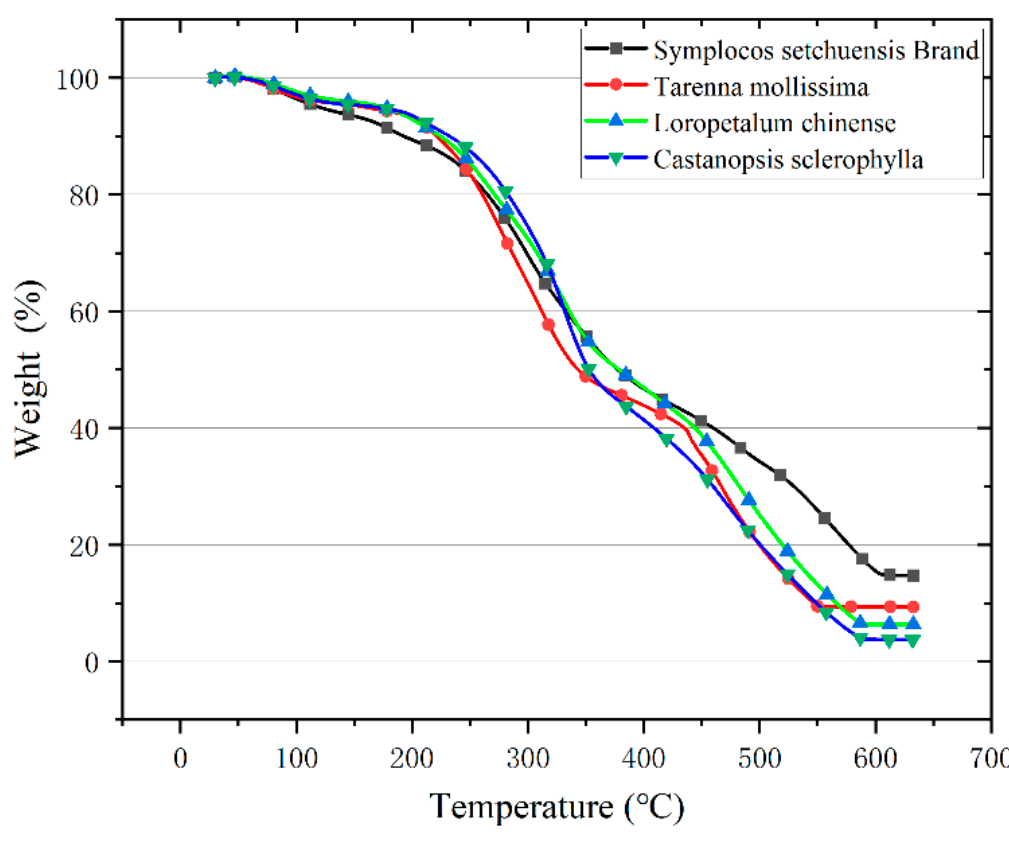
Figure 2. The weight loss process (TGA) of samples.